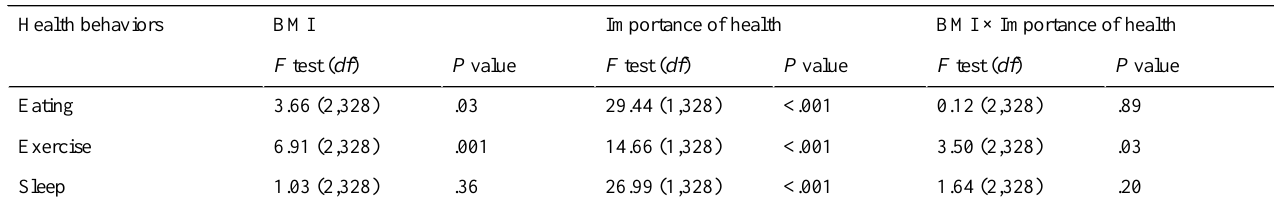
Table 3. Statistical results of the two-way analysis of variance for the effects of perceived importance of health and BMI on health behaviors.